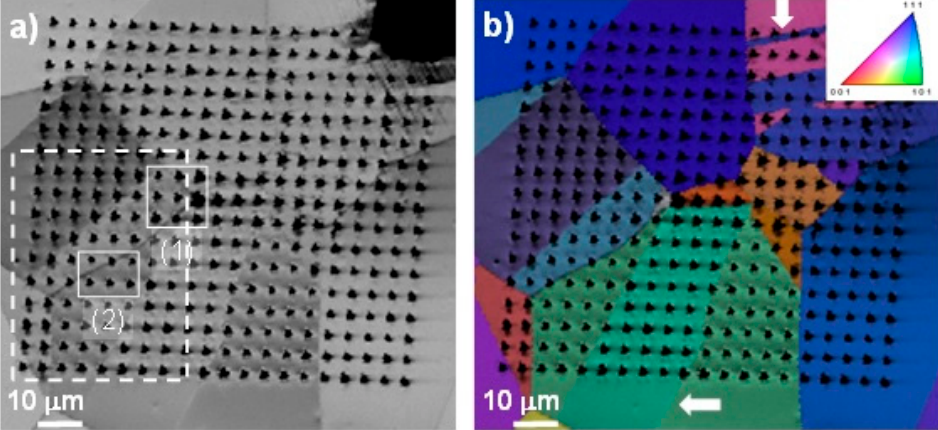
Figure 1. ( a ) Image quality (IQ) and ( b ) local crystallographic orientation map of an indentation array of 400 imprints (20 by 20) done at a maximum displacement into surface of around 200 nm. White arrows in Figure 1b show the pre-existing twins.